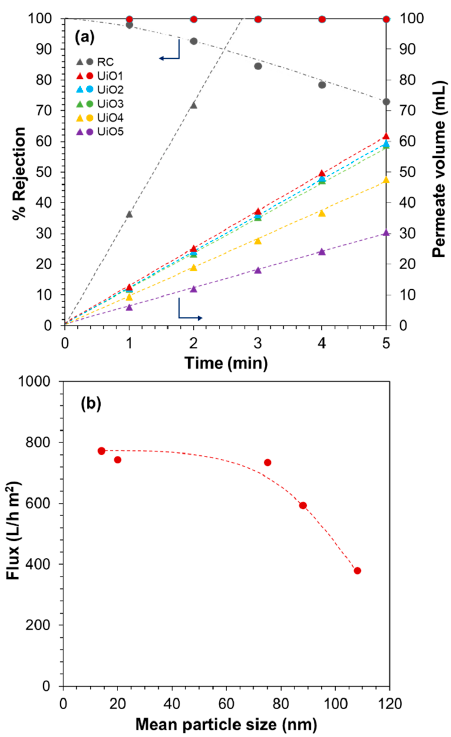
Figure 5. Filtration performance of UiO-66 composite membranes: ( a ) methylene blue rejection and permeate volume; ( b ) flux as a function of the UiO-66 particle size.